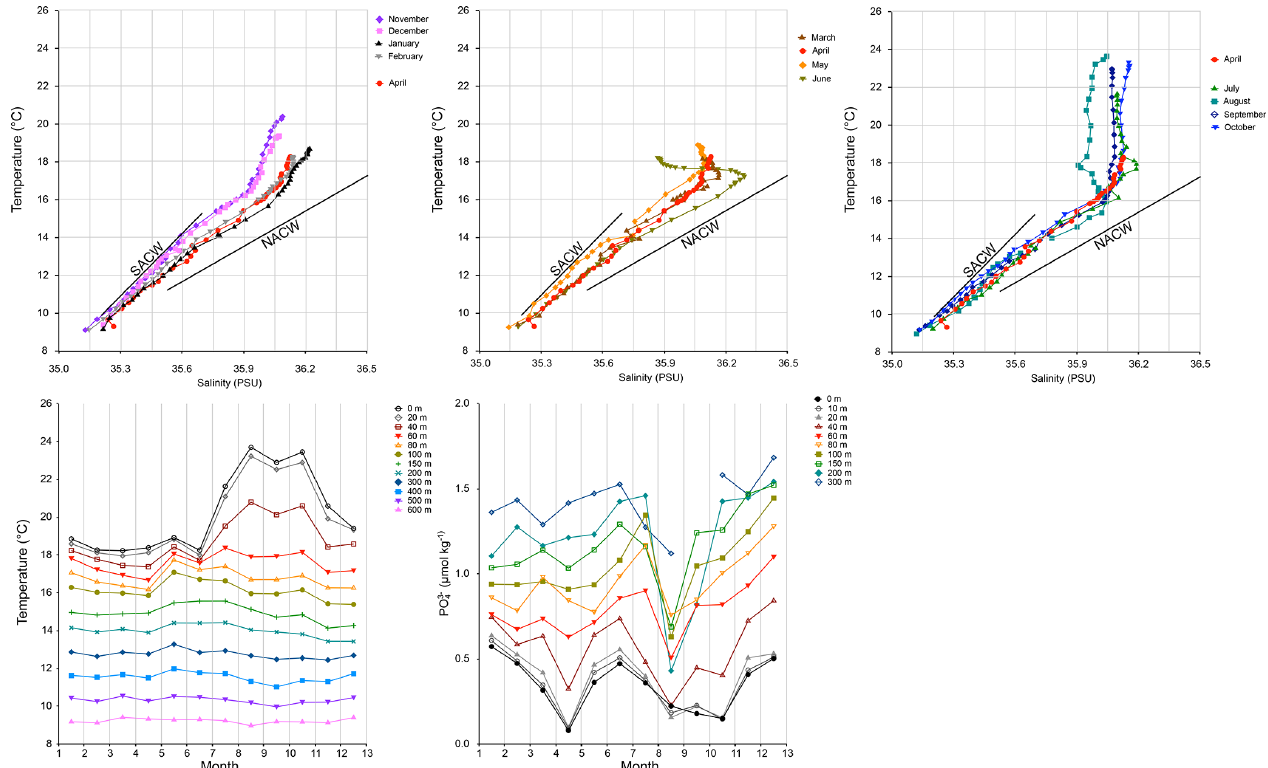
Figure 4. Oceanographic data from the World Ocean Atlas 2018 (WOA). The upper three panels show temperature–salinity diagrams for each month for the 1 ◦ square centred at 20.5 ◦ N, 18.5 ◦ W. Solid lines represent the North Atlantic Central Water (NACW) and the South Atlantic Central Water (SACW) (Locarini et al., 2018). The lower left panel shows water temperatures for different depths in the same 1 ◦ square (Zweng et al., 2019). The lower right panel shows monthly PO 3 − concentrations against depth for the 5 ◦ square centred at 22.5 ◦ N, 4 17.5 ◦ W (Garcia et al.,